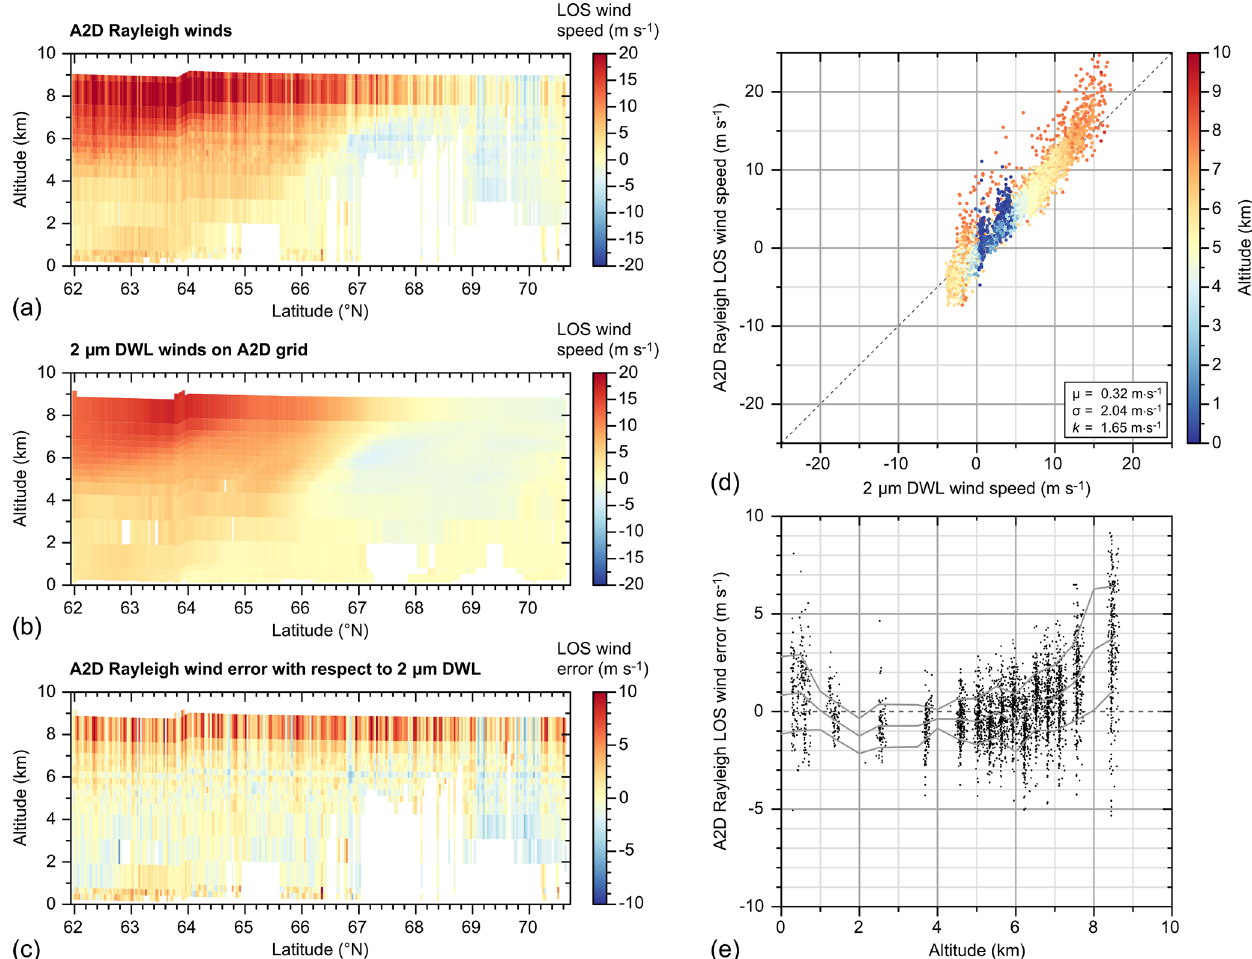
Figure 5. A2D Rayleigh wind for the AVATARI underflight on 16 September 2019 before the retrieval modifications. (a) A2D Rayleigh wind data, (b) 2µm DWL wind data averaged onto the A2D measurement grid, (c) wind speed differences between (a) and (b) , and (d) scatterplots comparing the wind data from (a) and (b) , where the colour-coding describes the centre altitude of the considered range bin. Panel (e) depicts the altitude dependence of the A2D Rayleigh wind error with respect to the 2µm DWL. The grey lines indicate the mean and standard deviation of the wind error in bins of